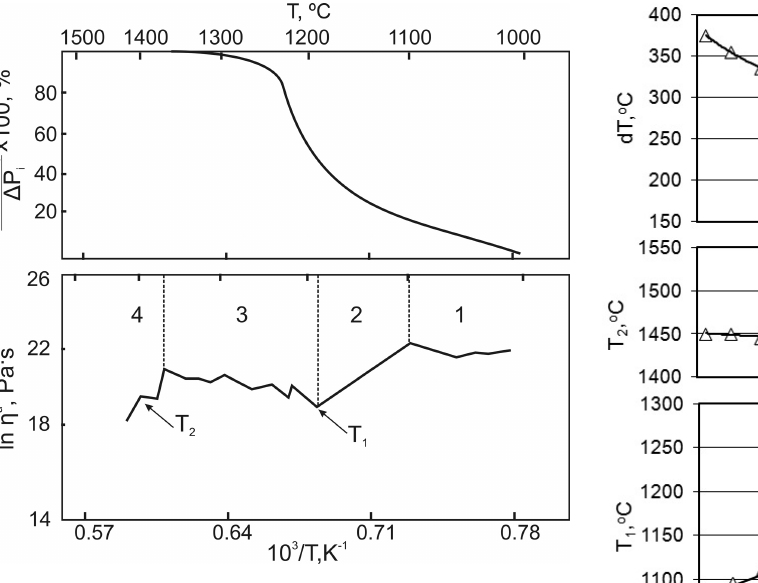
Figure 2. Typical (cid:2) a and pressure drop curves in Arrhenius coordinates.